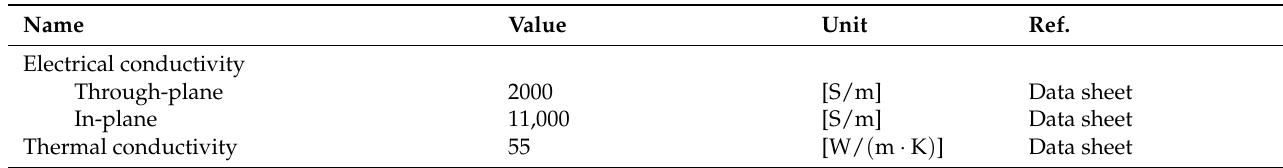
Table A4. Parameters for bipolar